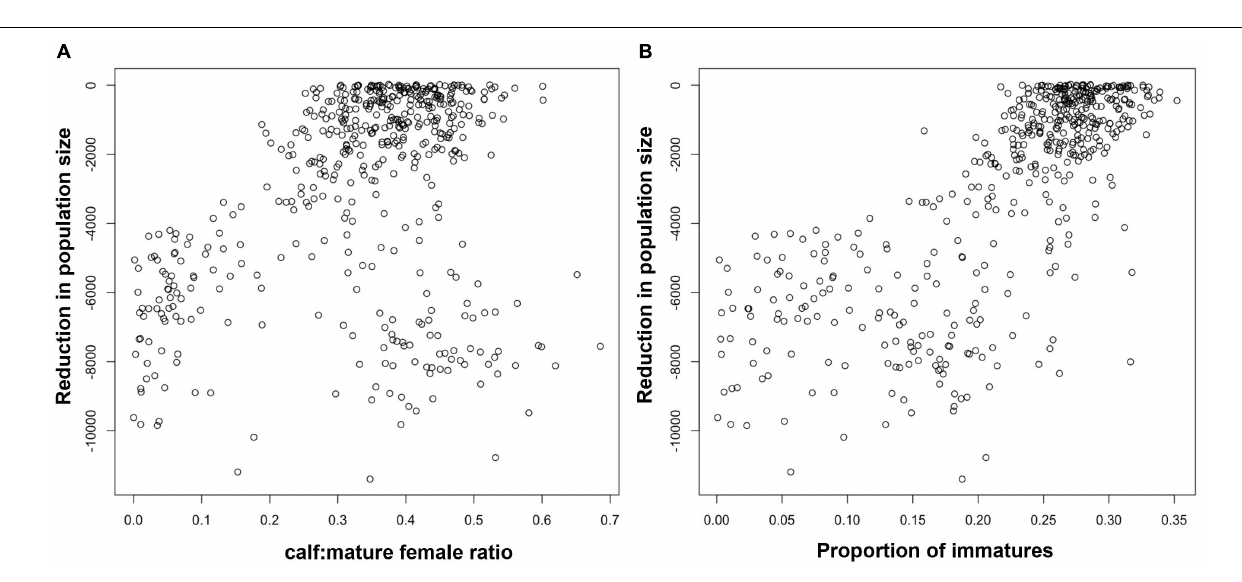
FIGURE 3 | Relationship between the maximum predicted reduction in harbor porpoise population size and (A) the ratio of calves to mature females in year 3, (B) the proportion of immature animals in year 5 when environmental variation was included in the